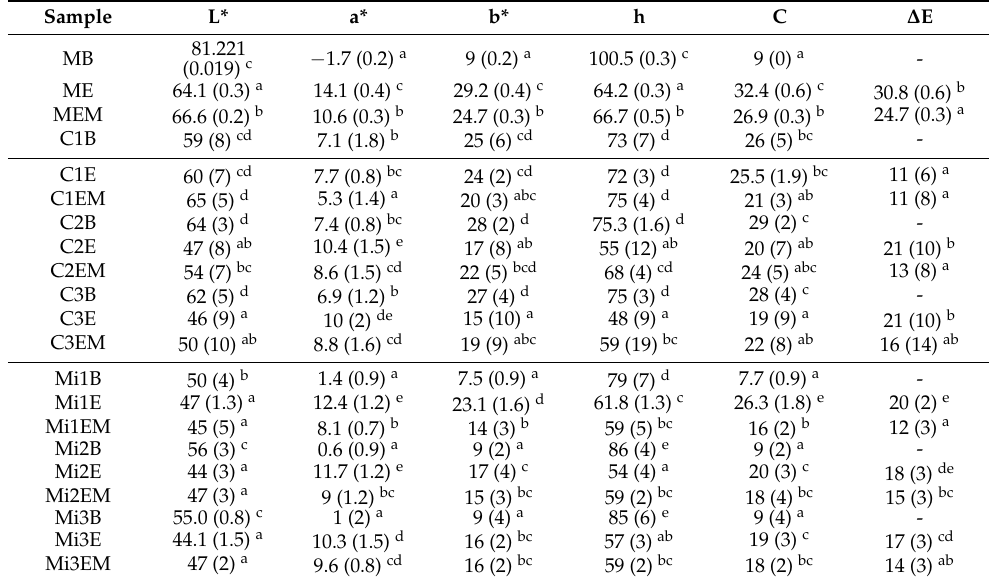
Table 2. Mean values and standard deviation in brackets of colorimetric parameters of the samples for a D65 illuminant and 10 ◦ observer. M: dough; C: crust; Mi; crumb B: control; E: rose hip; EM: rose hip maltodextrin. The numbers 1, 2 and 3 correspond with the height of samples